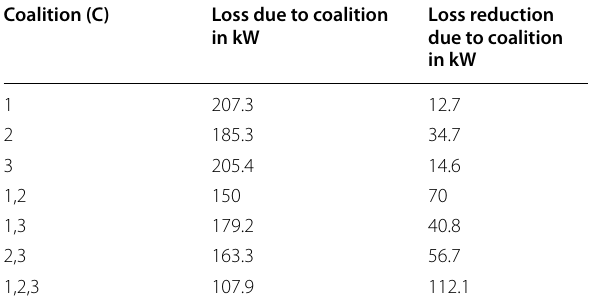
Table 2 Loss reduction for different coalitions